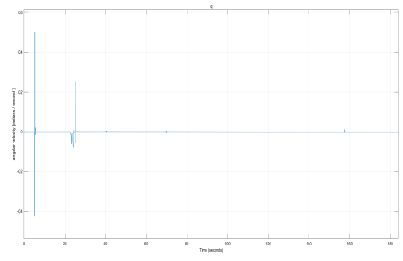
Figure 32. 3D view of Simulink flight path without attitude controller